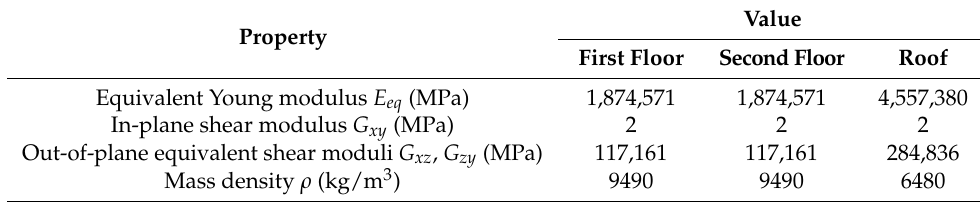
Table 9. Properties of the shell elements (thickness = 18 mm) representing the flexible diaphragms in configuration B3-AB.